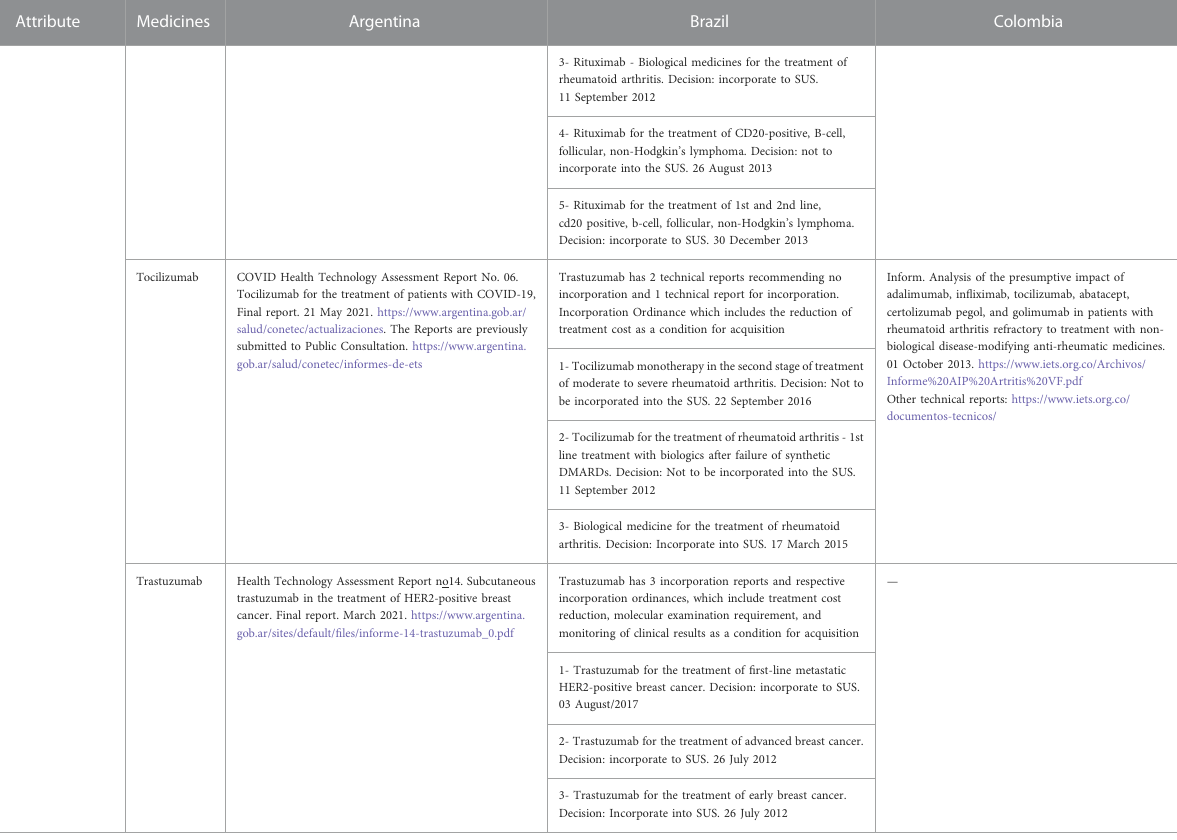
2-Trastuzumabforthetreatmentofadvancedbreastcancer. Decision: incorporate to SUS. 26 July 2012 3- Trastuzumab for the treatment of early breast cancer. Decision: Incorporate into SUS. 26 July